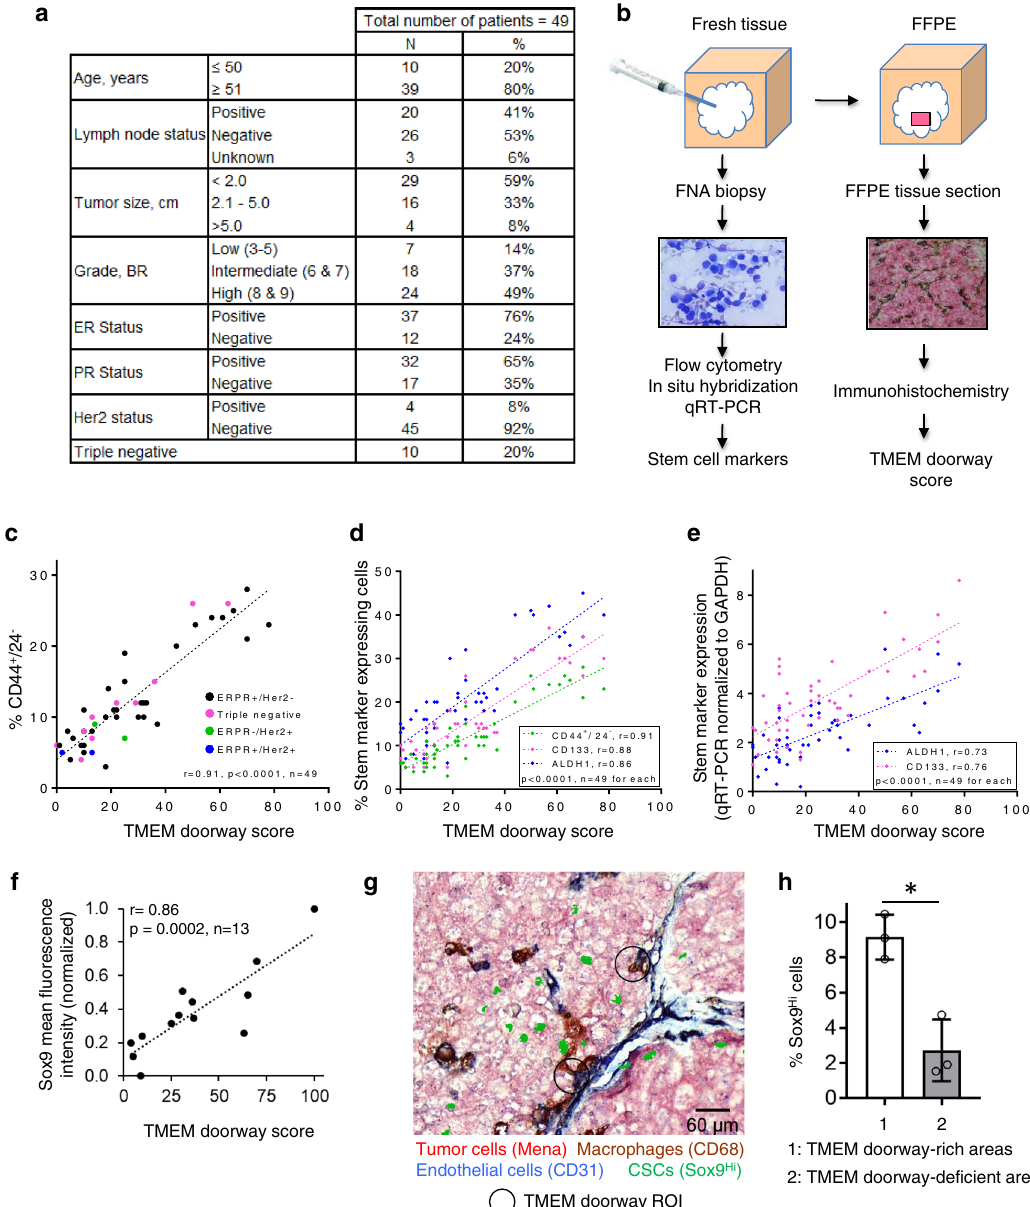
Fig. 8 Correlation of TMEM density with the proportion of tumor cells expressing stem cell markers in breast cancer tissues from patients. a Clinical and pathological characteristic of the 49 breast cancer cases included in the analysis. b A schematic of tissue collection procedure for the correlation of TMEM doorway score with the proportion of cancer cells expressing stem cell markers. c TMEM correlation with stem cell marker CD44 + /24 − in 49 invasive ductal carcinomas. Cells were collected by FNA and analyzed by fl ow cytometry for % cells expressing CD44 + /CD24 − . TMEM score from the same tumor tissue was correlated with the % CD44 + /24 − cells by Pearson ’ s correlation. d Correlation of TMEM with the percentage of breast cancer cells expressing stem cell markers CD44 + /24 − , ALDH1, and CD133 in 49 invasive ductal carcinomas from patients. Cells were collected by FNA and analyzed for CD133 and ALDH1 by in situ hybridization. CD44 + /24 − data are plotted from c . TMEM score from the same tumor tissue was correlated with the percentage of cancer cells expressing stem cell markers using Pearson ’ s correlation. e Correlation of TMEM with the percentage of breast cancer cells expressing stem cell markers ALDH1 and CD133 in 48 invasive ductal carcinomas from patients. Cells were collected by FNA and analyzed for CD133 and ALDH1 by qRT-PCR. TMEM score from the same tumor tissue was correlated with the percentage of cancer cells expressing stem cell markers using Pearson ’ s correlation. f Sox9 mean fl uorescence intensity in FFPE of the above human tissues ( n = 13) were correlated with the TMEM score for each human tissue. Pearson ’ s correlation r = 0.86, p = 0.0002, data normalized to the min and max Sox9 mean fl uorescence intensity values. g A composite image of TMEM staining (pink: Mena + tumor cells, brown: CD68 + macrophages, blue: CD31 + endothelial cells) and Sox9 Hi stem cells (green), showing enrichment of Sox9 Hi cells close to TMEM areas. Two TMEM doorway ROIs are highlighted with black circles. h Quanti fi cation of % Sox9 Hi cells in TMEM-rich and TMEM-de fi cient areas. n = 3 human tissues, data plotted as mean ± SD, paired two-tailed Student ’ s t -test, * p =